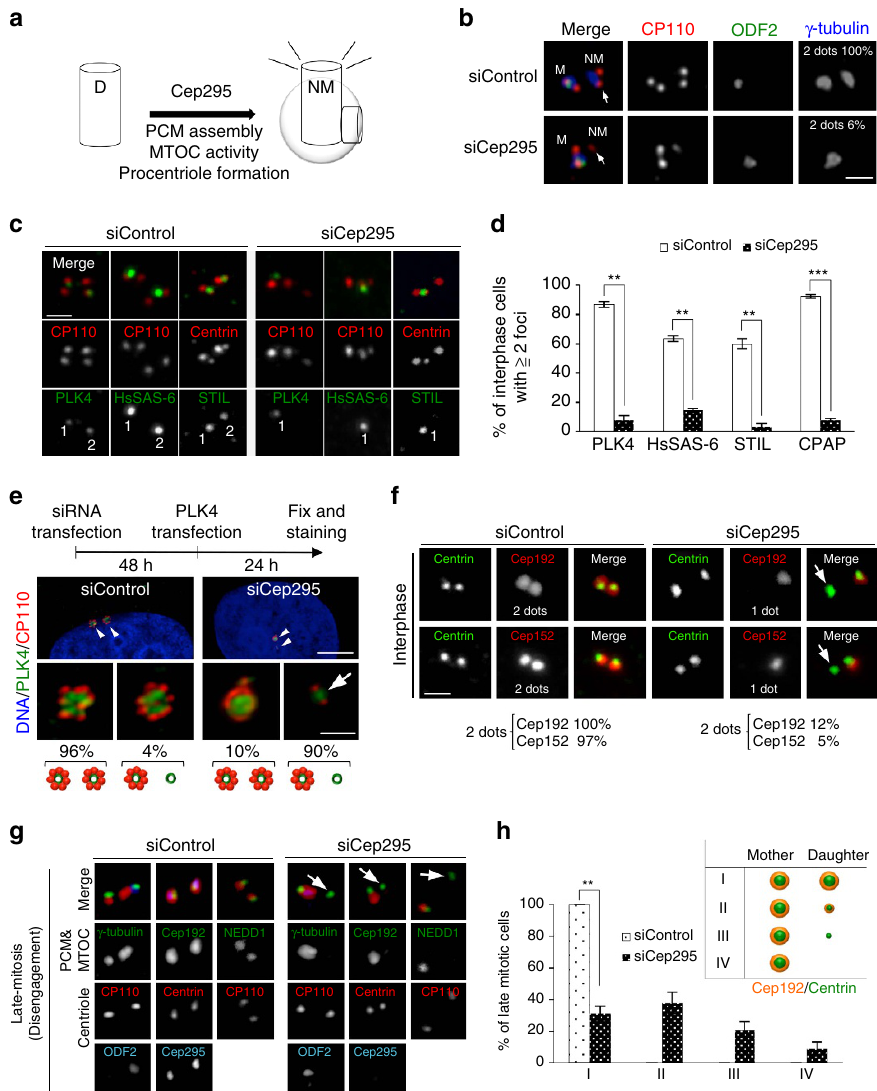
Figure 3 | Cep295 is essential for the ability of a new mother centriole to recruit pericentriolar material and to generate a procentriole. ( a ) Schematic of Cep295 function described in this figure. ( b ) Three colour staining of centrioles in control and Cep295-depleted cells. The cells were stained with the indicated antibodies. ODF2 was used as an older mother centriole marker. Arrows point to a new mother centriole (M: older mother centriole; NM: new mother centriole). Scale bar, 1 m m. ( c , d ) HeLa cells transfected with control siRNA or Cep295 siRNA for 72h were stained with indicated antibodies. CP110 and centrin were used as centriole markers 48 . Scale bar, 1 m m. ( c ) The number shown in the bottom panels represents the number of Plk4/HsSAS-6/STIL foci. ( d ) Histograms represent frequency of interphase cells with ^ 2 Plk4/HsSAS-6/STIL/CPAP foci in each condition. Values are mean percentages ± s.e.m from three independent experiments ( N ¼ 30 for each condition). *** P o 0.001; ** P o 0.01, (two-tailed t -test). ( e ) HeLa cells were treated with control siRNA or Cep295 siRNA, followed by transfection with an empty vector ( (cid:2) ) or, pCMV5-Plk4 D PEST-FLAG wild-type. The cells were stained with the indicated antibodies. An arrow points to the defect in multiple centriole formation induced by PLK4 over-expression, upon Cep295 depletion. Scale bars, 5 m m in the low-magnified view, 1 m m in the inset. Schematic illustrations show frequency of interphase cells with 2 or 1 over-duplicated centriole foci. ( f ) Cep295-depleted HeLa cells were stained with the indicated antibodies. Almost all control cells harbour Z 2 Cep192 and Z 2 Cep152 foci per cell, whereas only 12 and 5% of Cep295-depleted cells have Z 2 Cep192 and Z 2 Cep152 foci per cell, respectively. Scale bar, 1 m m. ( g , h ) To monitor the expression levels of Cep295 at the mother and daughter centrioles, the triple staining analysis was performed with the indicated antibodies as shown in the representative panels. HeLa cells were transfected with control or Cep295 siRNA for 24h. ( g ) Arrows point to the defective recruitment of PCM components in the Cep295-depleted cells just after disengagement. Scale bar, 1 m m. ( h ) Histograms represent frequency of late mitotic cells with the indicated category in each condition. Values are mean percentages ± s.e.m from three independent experiments ( N ¼ 30 for each condition). ** P o 0.01 (two-tailed t